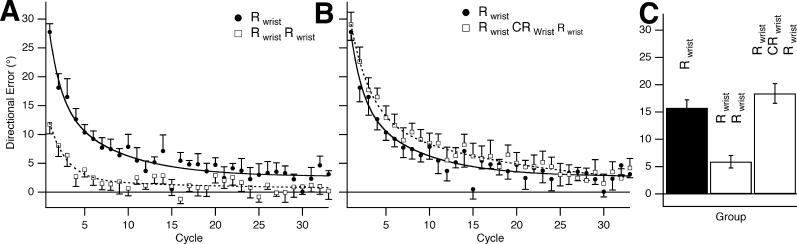
Savings and Interference Occur for Rotation Learning at the Wrist(A) Rwrist on day 1 (group 1, black circles and black curve) and on day 2 (group 2, white squares and dashed curve). Learning is shown by progressive reduction across cycles in the directional error at peak velocity. Points, representing the group average with standard error for each cycle, are fitted by a double-exponential function. There were substantial savings from day 1 to day 2.(B) Rwrist on day 1 (group 1, black circles and black curve) and after interference on day 2 (group 3, white squares and dashed curve). There were no savings from day 1 to day 2 after interference with CRwrist.(C) Bar graph showing a statistically significant difference in the reduction in mean directional error in the first six cycles for day 1 versus day 2 (groups 1 and 2, mean difference = 9.86°, p < 0.0001). This difference is absent with interference, with no statistically significant difference in the reduction in mean directional error in the first six cycles for day 1 versus day 2 (groups 1 and 3, mean difference = −2.64°, p = 0.22).